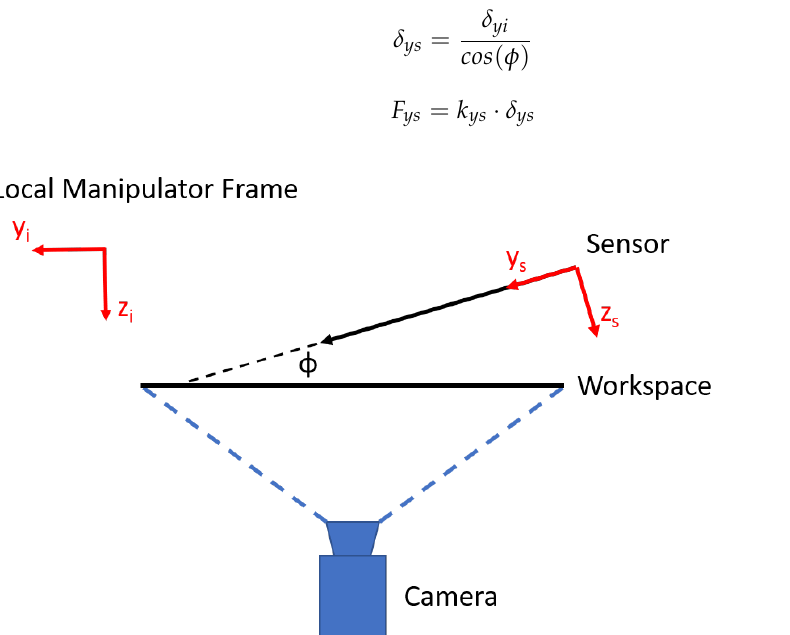
Figure 3. Schematic showing a side view of the system with the coordinate frames used to compute the